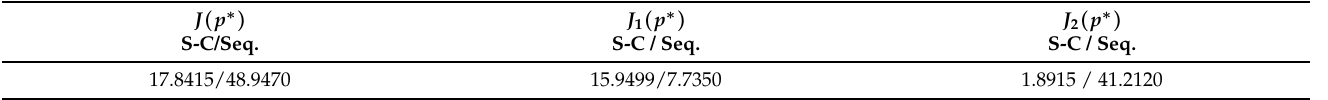
Table 8. Numerical results of the aggregate function J ( p ∗ ) , the walking capability J 1 ( p ∗ ) and energetic efficiency J 2 ( p ∗ ) design objectives related to the best solutions of structure-control (S-C) and sequential (Seq.) design approaches.